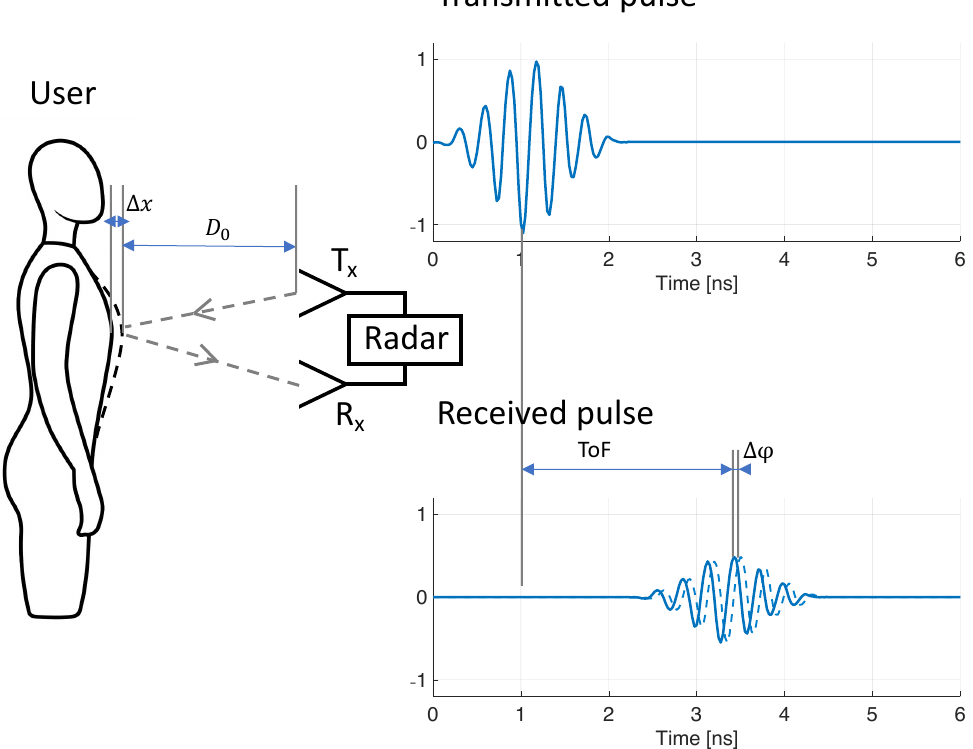
Figure 1. Mechanism of contactless respiratory rate monitoring using ultra-wideband radar. Res- piration results in mechanical displacement of the chest and abdominal wall ( ∆ x ), which causes variations to the time-of-flight ( ToF ) of the transmitted radar signal. By tracking these variations ( ∆ ϕ ) over time, respiratory rate can be